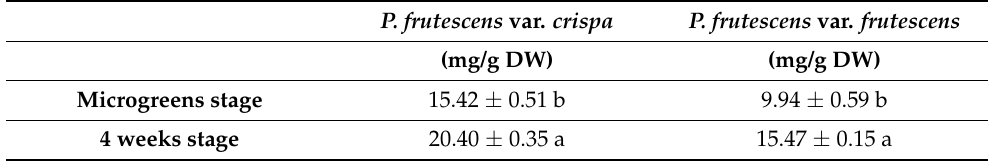
Table 1. Total phenolic content of red (var. crispa ) and green (var. frutescens ) Chinese basil at the microgreen stage and after further 4 weeks of growth.